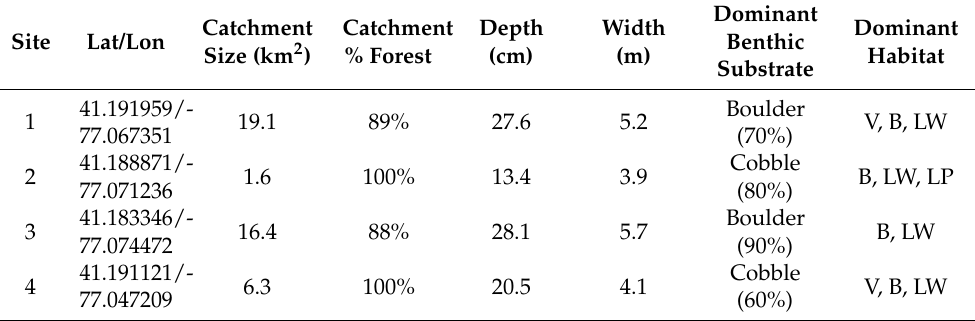
Table 1. Catchment characteristics and stream habitat conditions at the four sample sites. Depth and width values are averages. (V = aquatic vegetation; B = undercut bank; LW = loose woody debris; LP = leaf pack.)